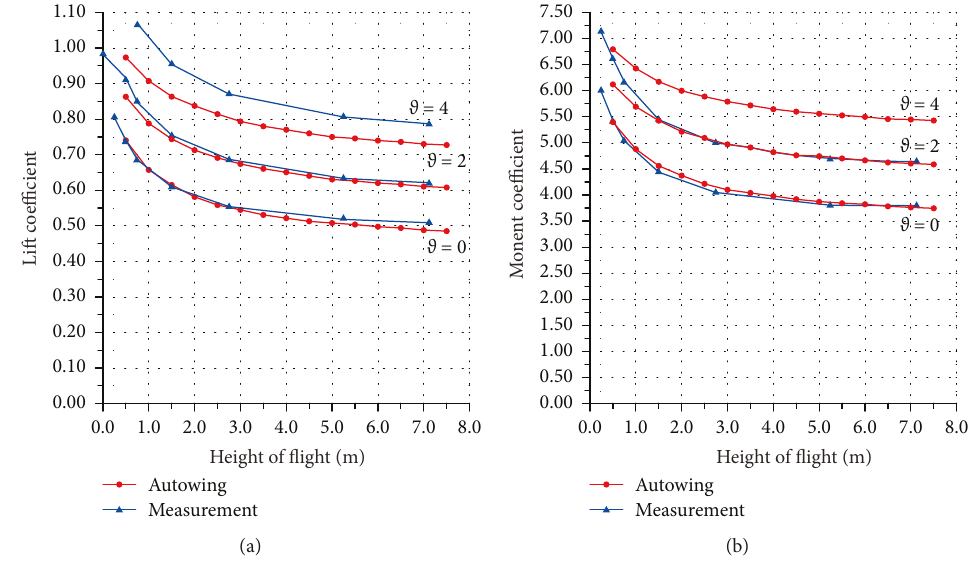
Figure 7: Lift (a) and pitching moment coe ffi cient (b) for the WIG craft Hoverwing 20 [24] versus height of fl